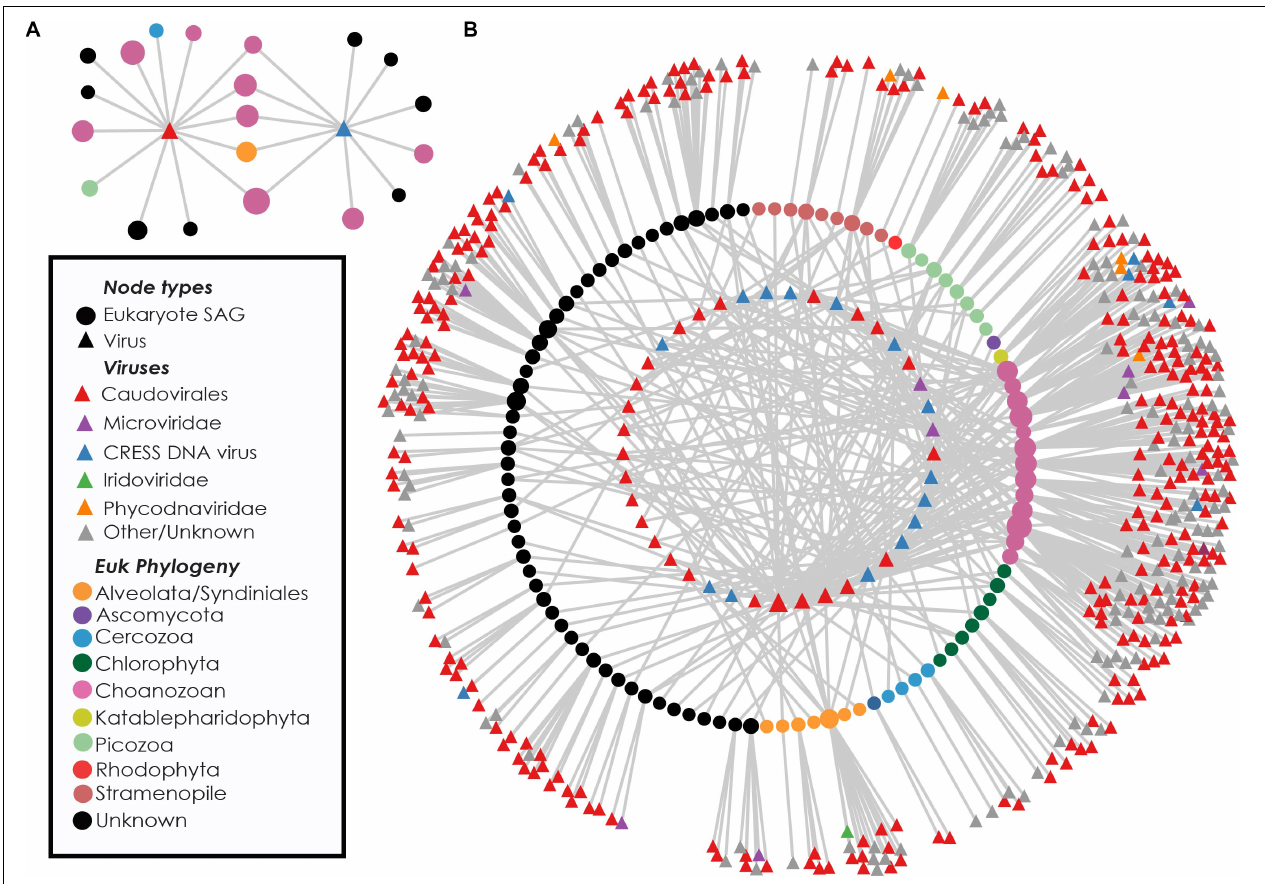
FIGURE 3 | Recovery of highly similar viral sequences from multiple Gulf of Maine protistan SAGs. Example networks containing two viruses recovered from multiple eukaryotic phyla. Connections indicate occurrence of viral sequences (triangles) within protist SAGs (circles) (A) . Network diagram showing viral content of eukaryote cells containing at least one virus found in multiple phyla. Innermost circle of nodes represent viruses found in more than one SAG. Middle circle of nodes represents protist SAGs. Outer nodes are singleton viral sequences. Nodes are sized based on network connectivity, with larger nodes indicating higher connectivity (B)